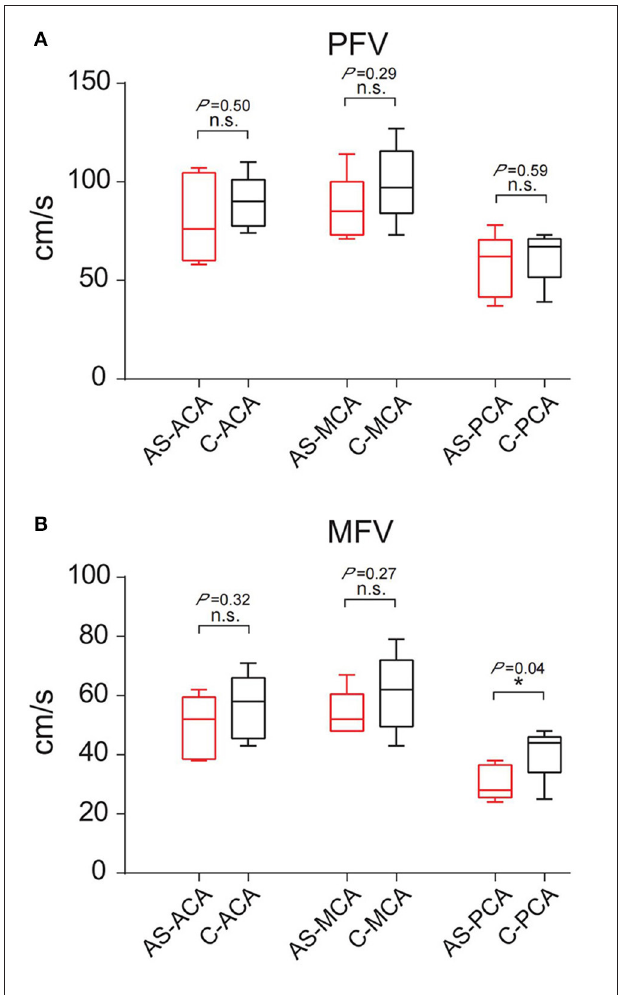
FIGURE 5 | Comparison of PFV and MFV of the corresponding vessels on the interictal discharge side and contralateral side. (A) PFV. (B) MFV. “*”: P < 0.05 ; n.s., no statistical significance; AS, abnormal side; C, contralateral; ACA, anterior cerebral artery; MCA, middle cerebral artery; PCA, posterior cerebral artery.